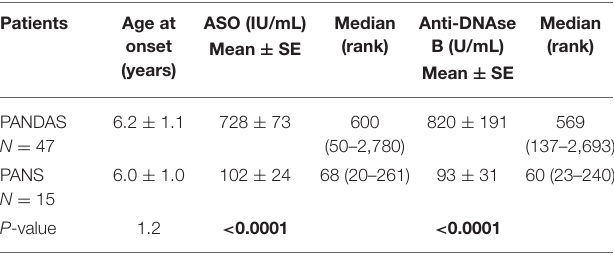
TABLE 3 | Age at onset and laboratory tests.